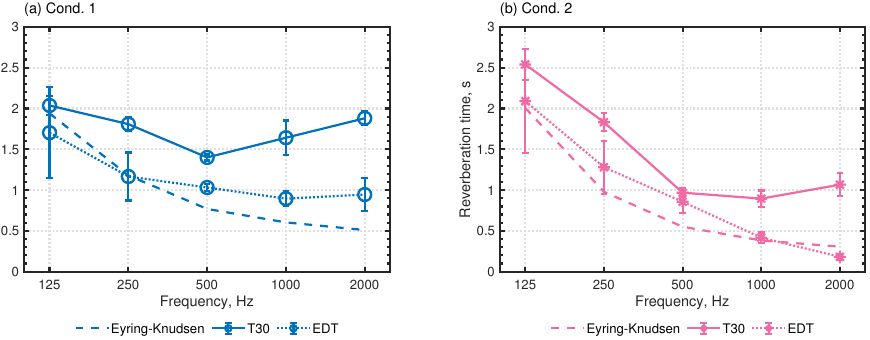
Figure 14. Comparisons of reverberation properties in the auditorium calculated using the Eyring– Knudsen formula and the wave-based solver: ( a ) Cond. 1 and ( b ) Cond. 2. We present examples for BRIRs calculated with FOA signals and HRIR at R3 and R4 for Cond. 1 in Figure 15. The BRIRs are calculated after rotating FOA signals so that the front of a listener is in φ = 180 ◦ . Consequently, direct sound arrives from the front at R3, whereas it comes from the left obliquely forward at R4. Such differences in directions of direct sound arrival are confirmed from BRIRs where direct components of B left and B right at R3 are of the same magnitude, whereas B left at R4 presents larger amplitude than B right . The result also reinforces the plausibility of the present auditorium acoustics simulation. Additionally, there are repeated intense reflections in both BRIRs. We can expect to perceive flutter echoes at receivers R3 and R4 in Cond.